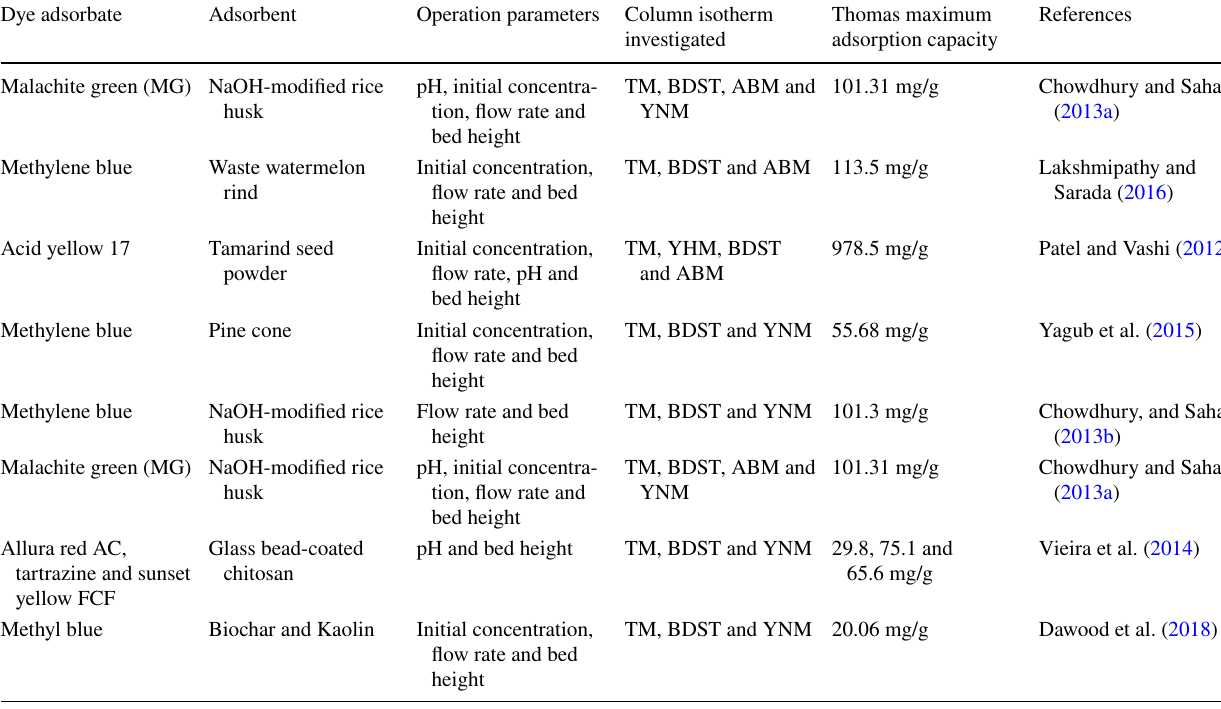
Table 5 Details of column adsorption studies of